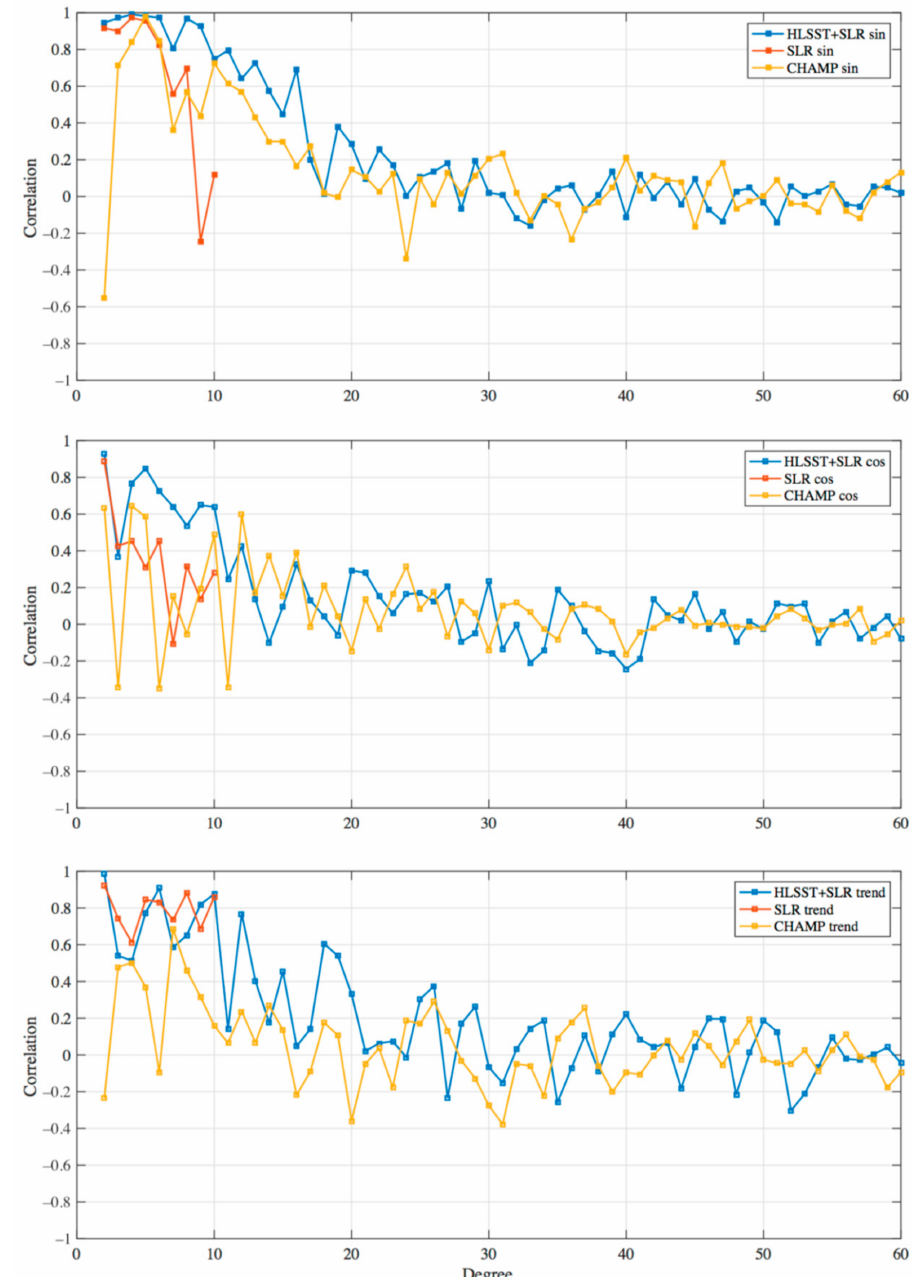
Figure 4. Degree-specific correlations for the annual sine term ( top ), the annual cosine term ( middle ), and the trend ( bottom ) of HLSST+SLR, SLR, CHAMP monthly solutions with GRACE CSR solutions over the common period from January 2003 to December